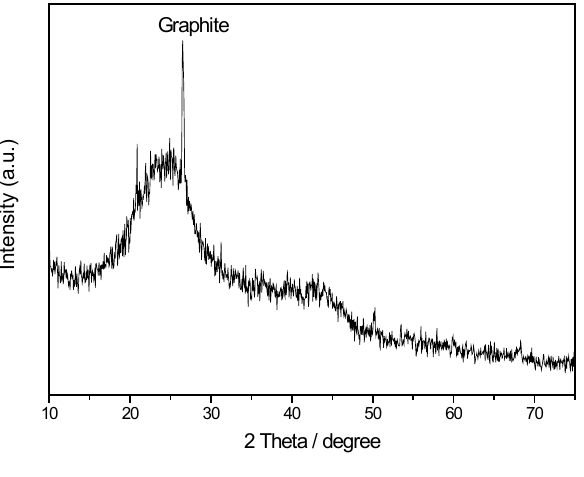
Figure 1: XRD pattern of the Pt/C